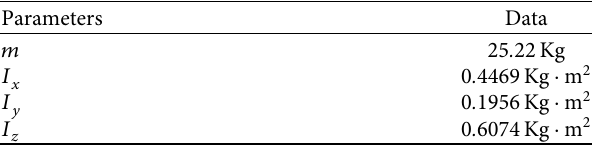
Table 1: Parameters of the CMG.